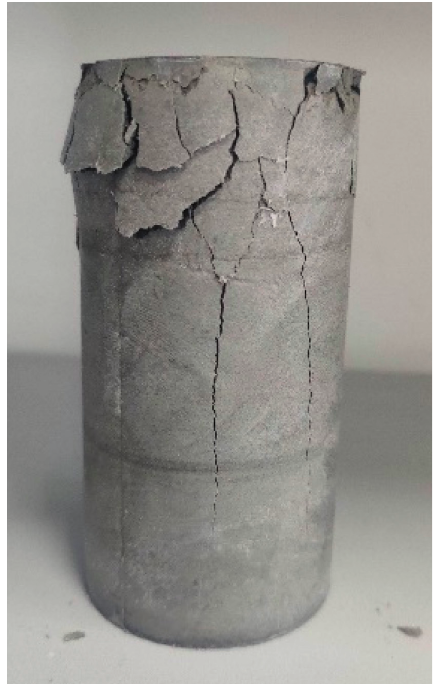
Figure 12: The final destruction diagram of the filling